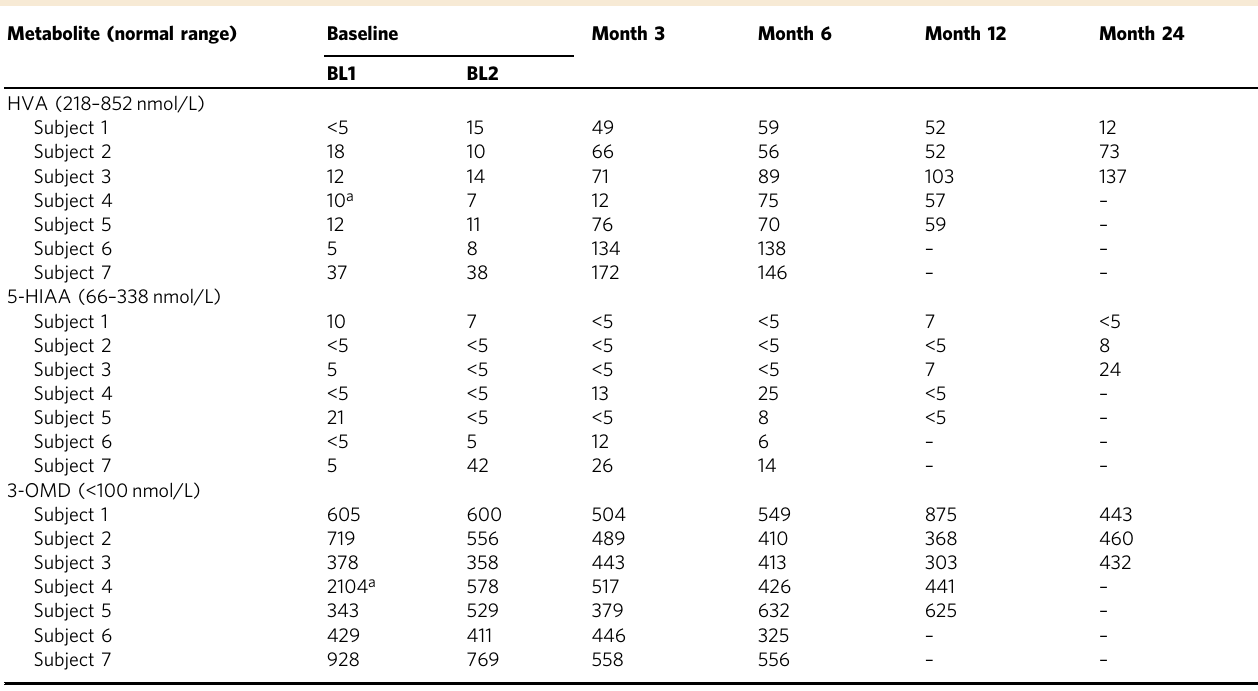
Fig. 2 CSF Neurotransmitter metabolites. Concentrations of CSF metabolites measured at 2 separate baseline (BL) timepoints, Month 3, Month 6, and Month 12, in individual subjects in Cohort 1 (low-dose, black markers); and Cohort 2 (high-dose, white markers) and summarized at each timepoint as the group median (bars). A Homovanillic acid (HVA), the dopamine metabolite, was signi fi cantly higher at each post-operative timepoint compared to the baseline mean (inverted bracket; (* p = 0.0078 at Months 3 and 6, p = 0.0313 at Month 12, one-tailed Wilcoxon signed-rank test). Lower limit of normal range: 218 nmol/L (dotted line). B 5-hydroxyindoleacetic acid (5-HIAA), the serotonin metabolite, did not change after gene delivery. Lower limit of normal range: 66 nmol/L (dotted line). C 3-O-methyldopa (3-OMD) was elevated in all subjects at all timepoints. Normal: <100 nmol/L (dotted line). Source data can be found in Table 2. Table 2 CSF neurotransmitter